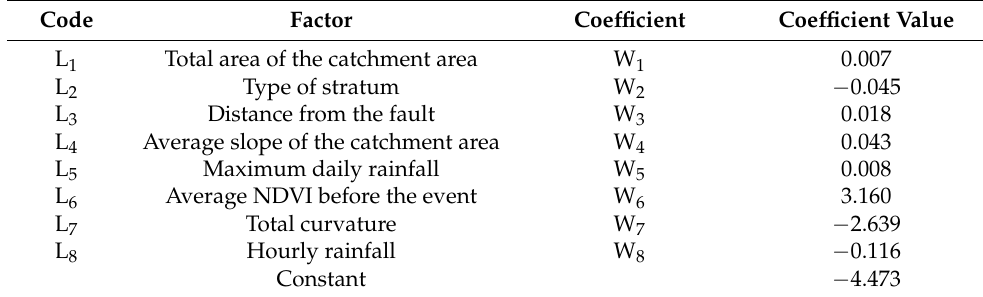
Table 14. Table of coefficients for logistic regression. Code Factor Coefficient Coefficient Value L 1 Total area of the catchment area